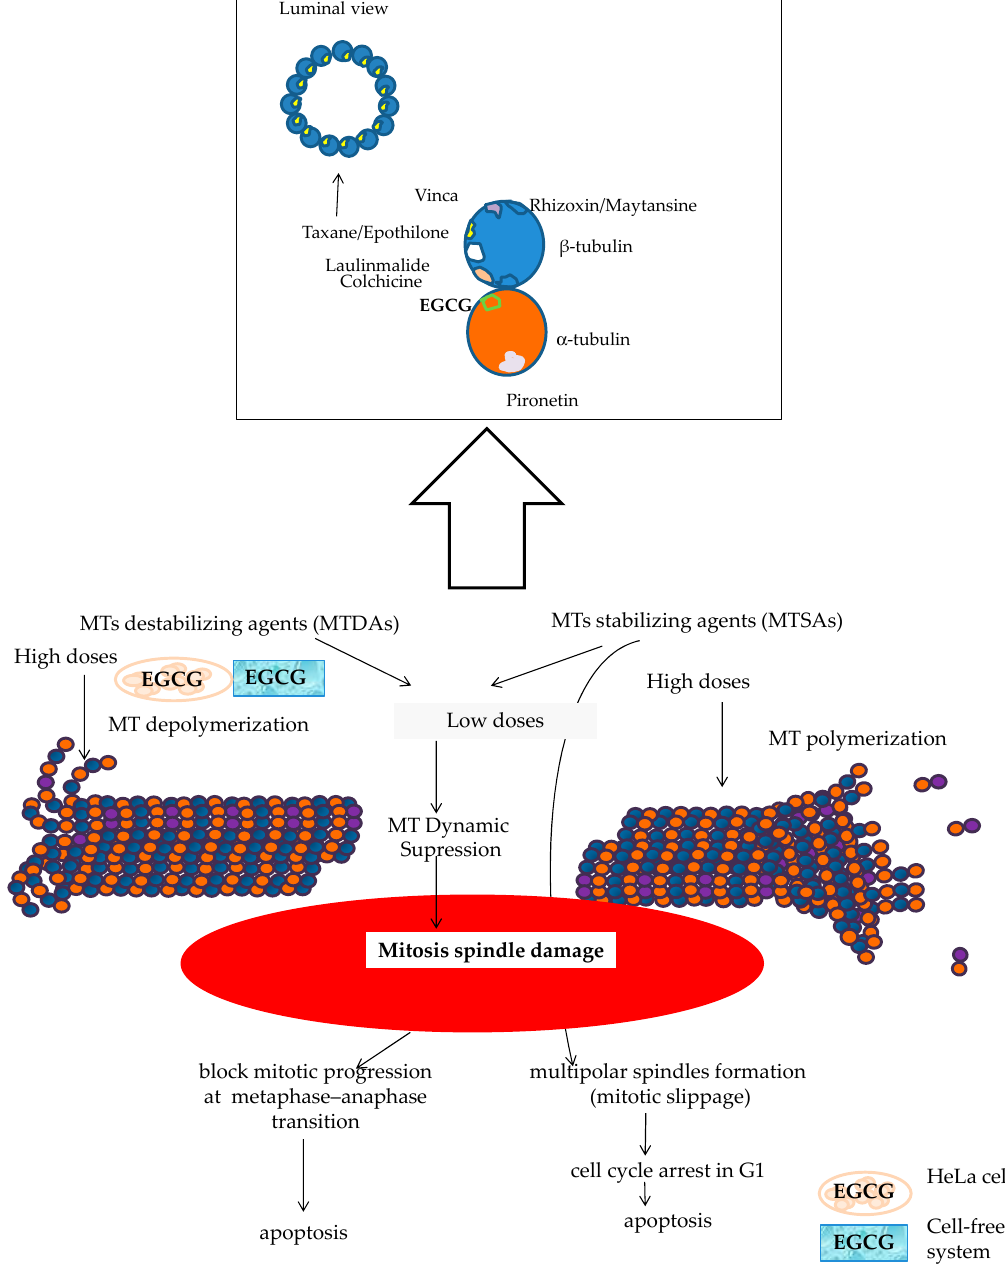
Figure 13. Types of MTAs according to their effect on microtubules: MTDAs and MTSAs. MTDAs and MTSAs induce depolarization and polarization of microtubules, respectively, at high doses, whereas both MTAs cause suppression of MTs dynamics at low doses [105]. Main MTDAs- and MTSAs-domain binding drugs are showed. The schematic representation of drug-binding sites on tubulin is based on McLoughlin et al. [119] with modifications. CATs could interact with tubulin [107–109]. Based on in silico data, it appeared that some CATs bind to the α -subunit of tubulin, close to the colchicine site [108]. DOCE binds to the β -tubulin subunits of microtubules [124], at taxane-binding side, inducing suppression of MTs dynamics (low doses) or stabilization of microtubules, and thereafter cell-cycle arrest effects [105]. Abbreviations: EGCG, epigallocatechin gallate; MT, microtubule; MTDAs, microtubule-destabilizing agents; MTSAs, microtubule-stabilizing agents.